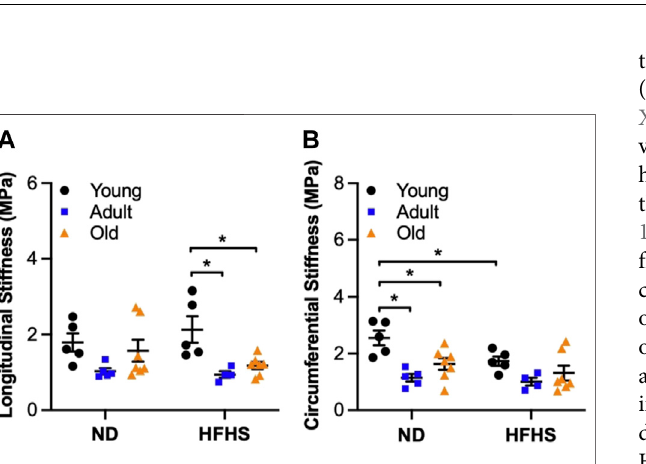
FIGURE 5 | Comparison of theoretical calculated strain energy density (mean ± SEM) as a function of age (young, adult, and old) and diet (ND and HFHS). (A – E) : Theoreticalcalculatedstrainenergydensity asafunctionoftheapplied pressure. The fi vesub- fi guresshowtheeffectofdiet (A – C) andaging (D,E) onstrainenergy.The bar graphs (F,G) show the averaged (mean ± SEM) normalized difference in strain energy (* p < 0.05).